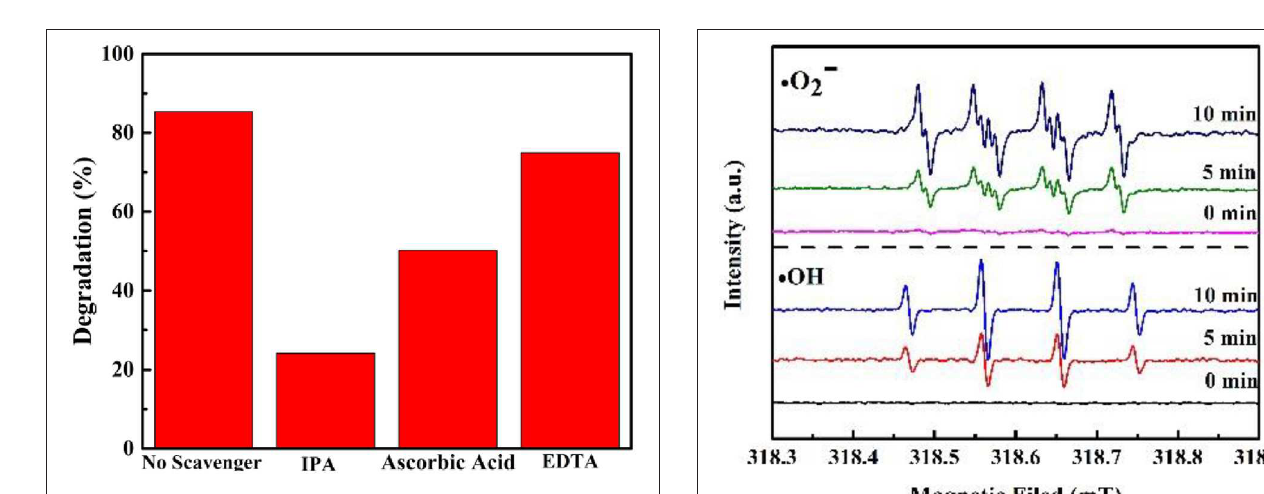
FIGURE 8 | Effects of a series of scavengers on the degradation of RhB solution by heterojunction LSO-CN-85.